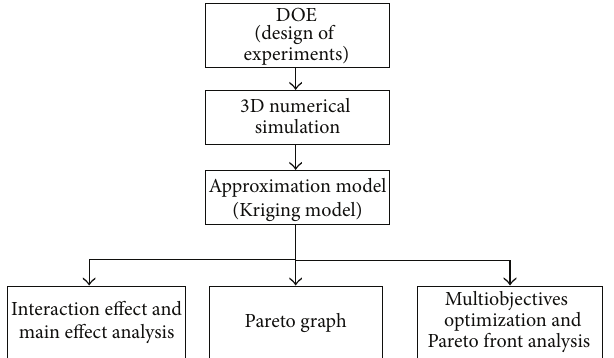
Figure 1: The flow chart of parametric study